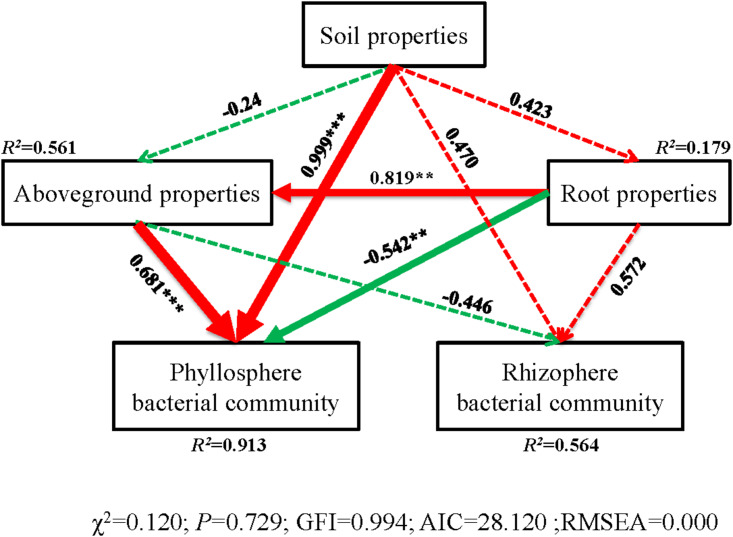
Structural equation model (SEM) illustrating the effects of soil properties on physicochemical characteristics (aboveground and root) and bacterial communities of phyllosphere and rhizophere. Continuous and dashed arrows represent the significant and non-significant relationships, respectively. Adjacent number that are labeled in the same direction as the arrow represents path coefficients, and the width of the arrow is in proportion to the degree of path coefficients. Green and red arrows indicate positive and negative relationships, respectively. R2 values indicate the proportion of variance explained by each variable. Significance levels are denoted with **P < 0.01 and ***P < 0.001. Standardized total effects (direct plus indirect effects) calculated by the SEM are displayed below the SEM. The low chi-square (χχ2), nonsignificant non-significant probability level (P > 0.05), high goodness-of-fit index (GFI > 0.90), low Akaike information criteria (AIC), and low root-mean-square errors of approximation (RMSEA < 0.05) listed below the SEMs indicate that our data matches the hypothetical models.